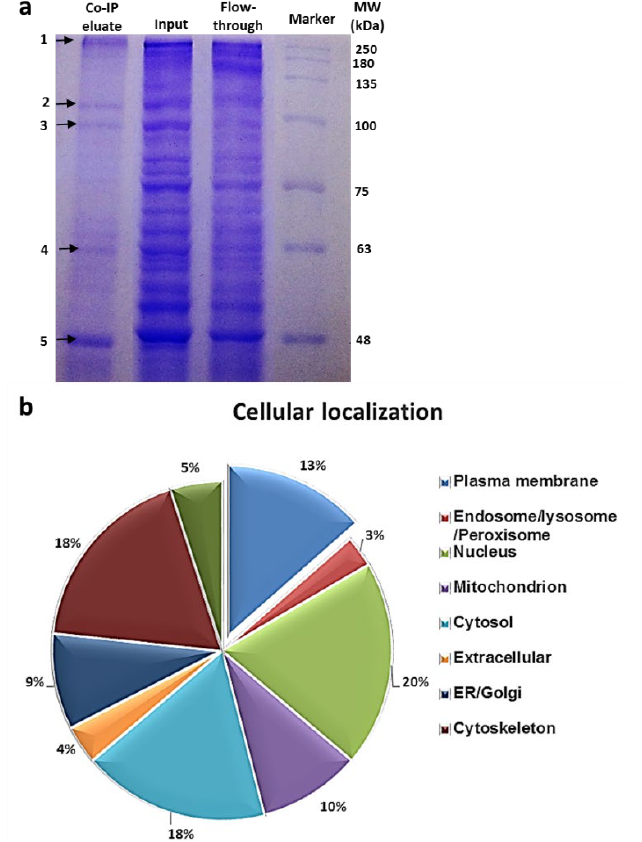
Figure 4. Identification of the Hsp90 interacting partners. ( a ) SDS-PAGE and Coomassie blue staining of proteins obtained in co-immunoprecipitation assay with anti-Hsp90 α antibodies using cell lysates prepared from ATRA-stimulated THP-1 cells. Immunoprecipitated proteins (lane 1) or total cell lysates (lane 2) or unbounded proteins (lane 3) were separated by SDS-PAGE and visualized by Coomassie blue staining. Five main bands (indicated by arrows) obtained via Co-IP were eluted separately and analyzed by LC-MS/MS. ( b ) Cellular localization of Hsp90 interacting proteins by bioinformatic analysis. Hsp90 interacting partners identified by LC-MS/MS were analyzed for cellular localization. The identified proteins were classified based on their subcellular localization, of which 13% were plasma membrane proteins.